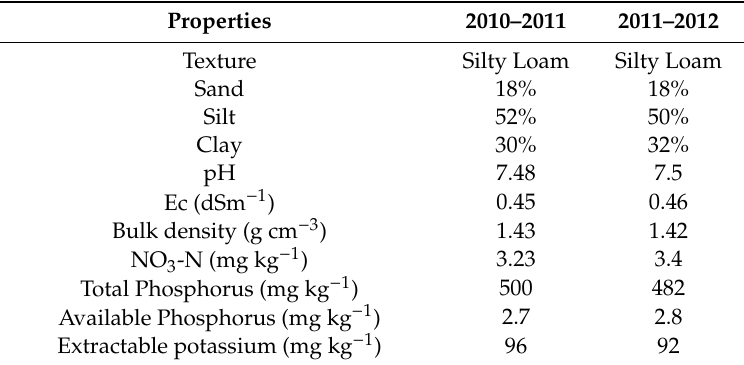
Table 3. Physicochemical, biological and biochemical properties of